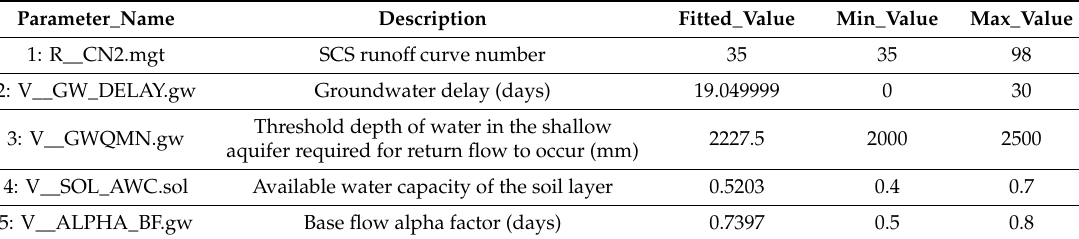
Table 10. Model calibration parameters.